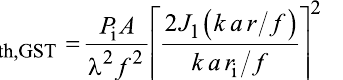
the total energy of the respective pulse. The relation between the threshold fluence and the radius r i for a certain total energy P i is given by